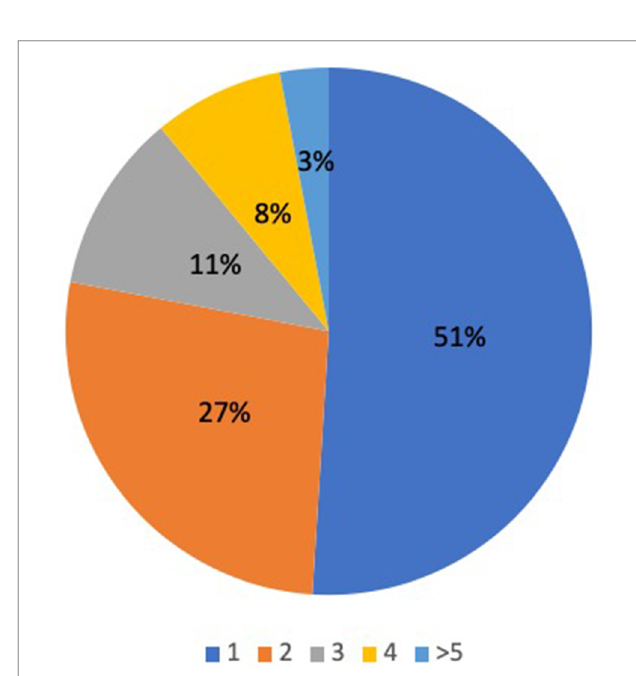
FIGURE 3 Total number of FPIES trigger foods among the